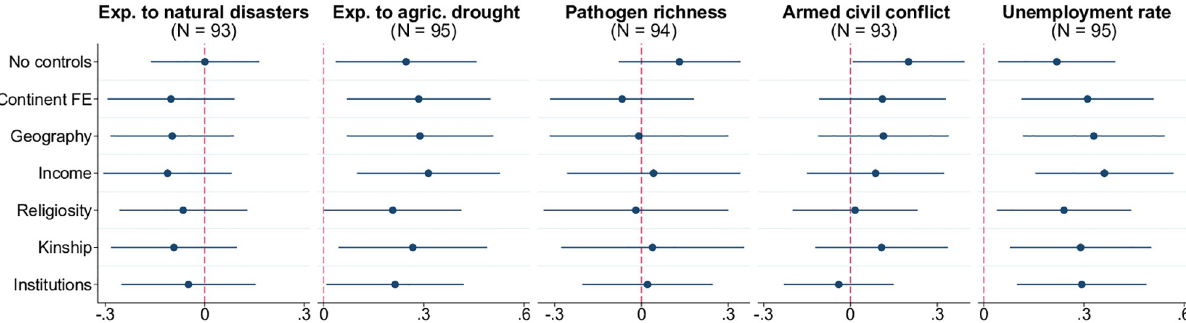
Fig 9. Witchcraft beliefs and exposure to misfortunes. Each panel of the figure presents the results of estimating 7 different models, in which the prevalence of witchcraft beliefs at the country level is regressed on the metric of exposure to misfortune indicated in the panel title, along with a set of control variables. The latter is defined as follows according to the tickmarks on the vertical axis: 1) none for “No controls”, 2) only continental fixed effects for “Continent FE”, 3) continental fixed effects and baseline geographic controls (absolute latitude, terrain ruggedness, agricultural suitability of land, distance to the coastline) for “Geography.” The remaining 4 models, named “Income,” “Religiosity,” “Kinship,” and “Institutions” include, respectively, real GDP per capita, average religiosity, kinship intensity index, and the rule-of-law index (in addition to continental fixed effects and geographic variables). The round marker represents the point estimate for the coefficient on the respective metric of exposure to misfortune, and the linear segment around each marker is the corresponding 95% confidence interval based on heteroskedasticity-robust standard errors. Confidence intervals that do not cross the reference vertical line at 0 correspond to statistical significance of the relevant point estimate at the 5% level. Sample size N indicated in parentheses. The key variables are standardized to have zero mean and unit standard deviation in relevant